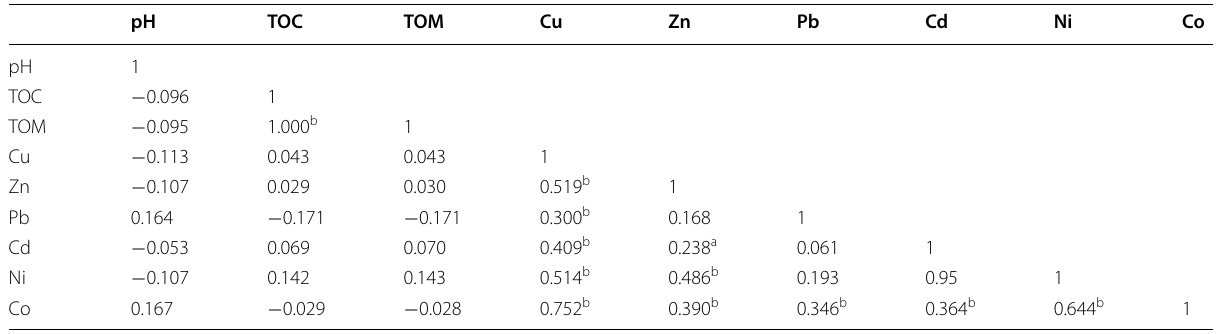
a Correlation is significant at the 0.05 level (2-tailed) b Correlation is significant at the 0.01 level